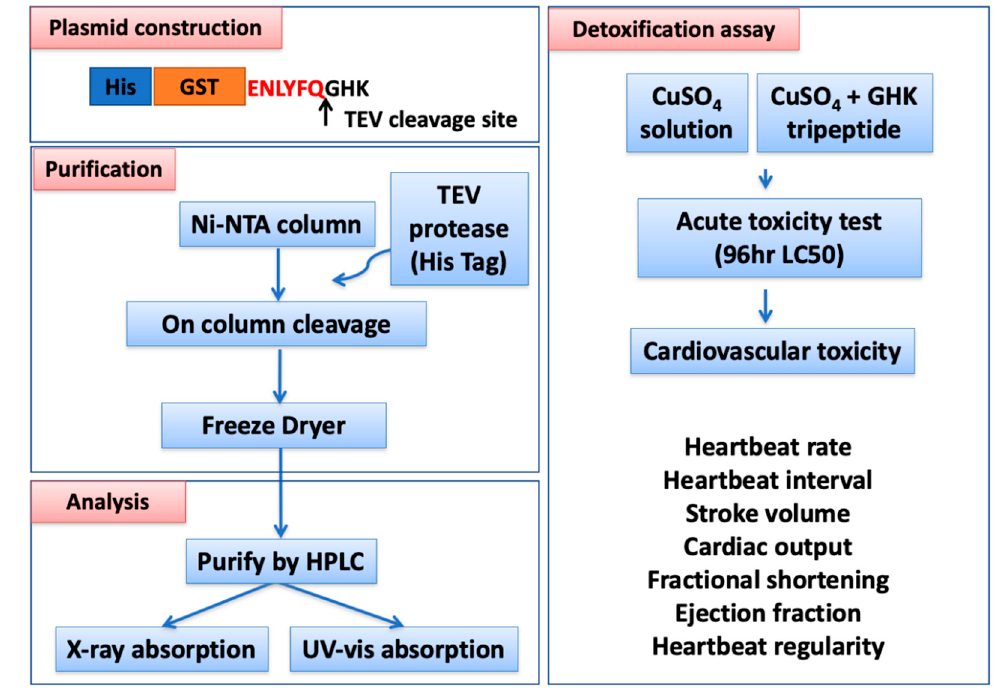
Figure 1. Overview of the experimental design and workflow, including four major parts, namely, plasmid construction, recombinant GHK (glycyl-histidyl-lysine) tripeptide purification, biochemical property analysis, and detoxification assays, in zebrafish embryos.